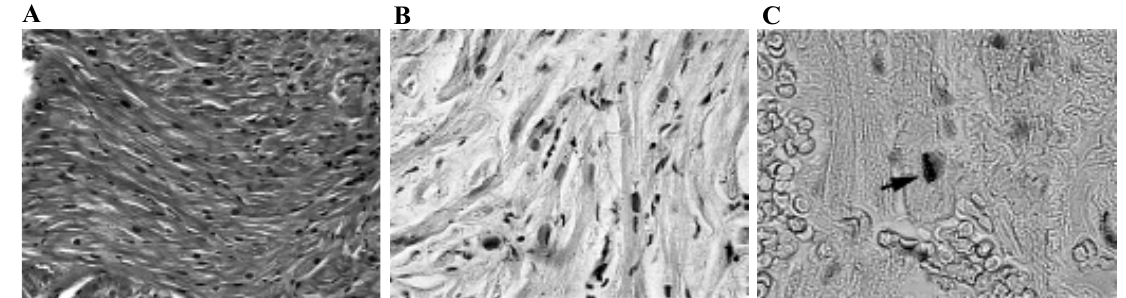
Fig. 1 – A- Hematoxylin and Eosin stain. 100X. Myocardium with a normal aspect. Pre-operative Off-Pump group. B - TUNEL. 200X. Pre- operative Off-Pump group. Observe the absence marked nuclei. C - TUNEL.400X. Post-operative CPB group. Observe the marked nucleus